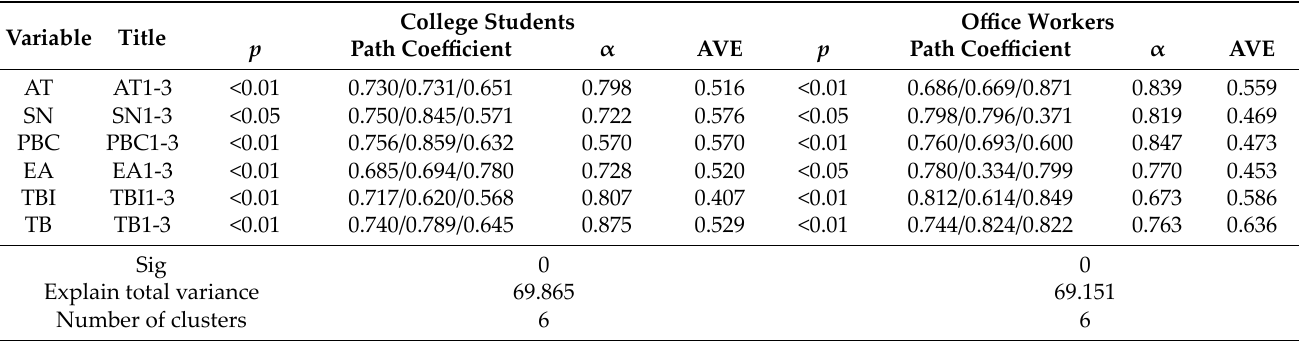
Table 3. Model parameter